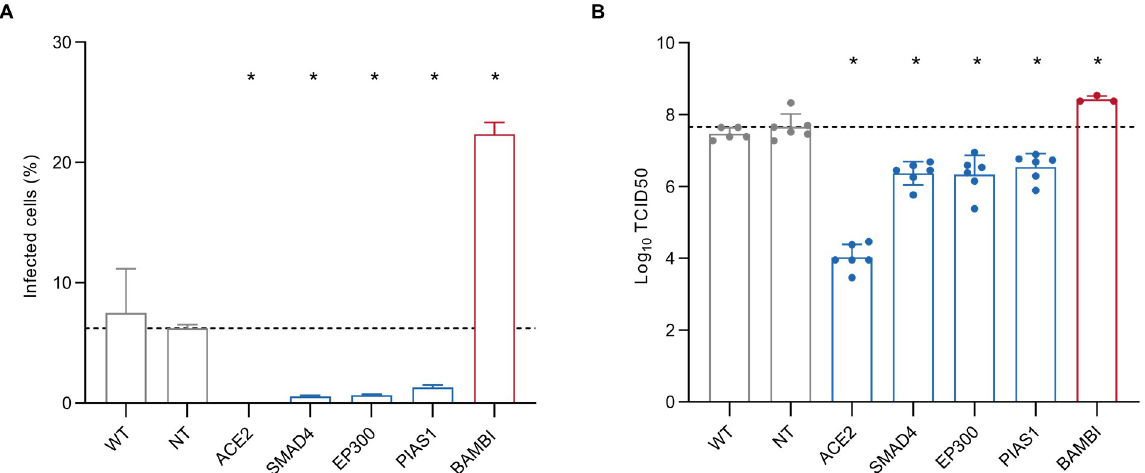
Fig 5. ACE2 regulators influence cellular sensitivity to SARS-CoV-2 infection. (A) Percentage of either wild-type or CRISPR-targeted cells with positive staining for SARS-CoV-2 nucleocapsid protein at 2 days post-infection with SARS-CoV-2 at MOI 1. An average of 214 fields of view (range 151–295) were analyzed for each condition over 2 independent biologic replicates. Error bars indicate standard deviation. (B) Infectious titers of cellular supernatants collected at 2 days post-infection with SARS-CoV-2 at MOI 1, plotted as log 10 (TCID50) with error bars indicating standard deviation. For both experiments, asterisks indicate p < 0.05 relative to nontargeting controls by Student’s t-test.